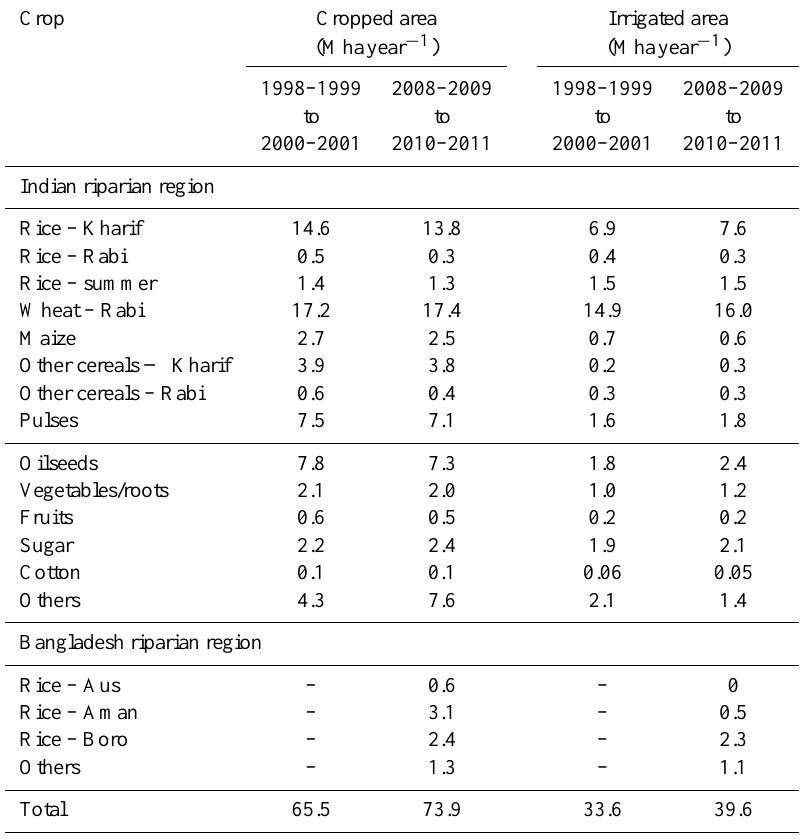
Table 2. Cropped and irrigated areas of major crops grown in the basin.